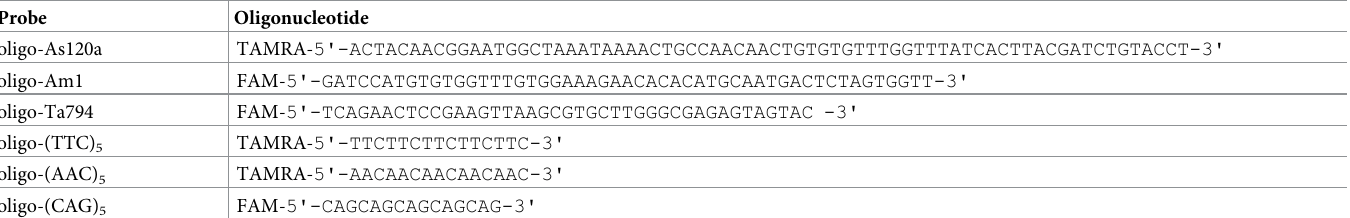
Table 2. Oligonucleotide probes used for fluorescence in situ hybridization (FISH) analysis.